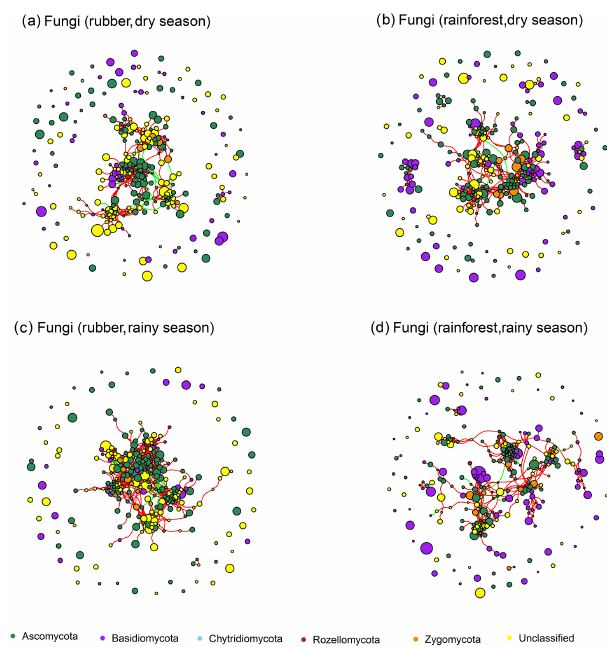
Figure 3. The soil fungal network structure of rubber plantations and tropical rainforests in the dry and rainy seasons. Red lines indi- cate a positive correlation between OTUs, and green lines indicate a negative correlation. The absolute value of the correlation coeffi- cient ρ > 0 . 6 ( P < 0 .